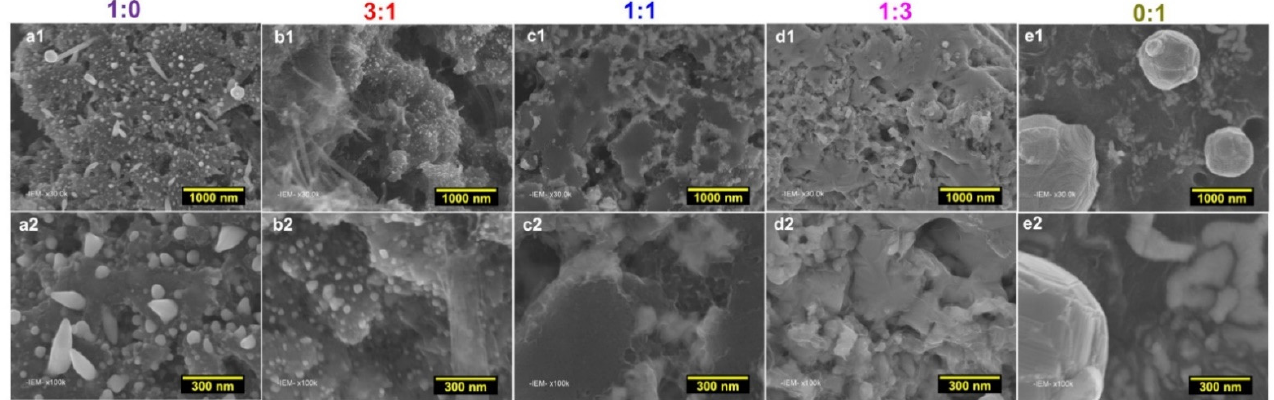
Figure 3. SEM images (at different magnifications) of the as-fabricated electrocatalysts for PANI-Ni:PANI-Co ratios of 1:0 ( a1 , a2 ), 3:1 ( b1 , b2 ), 1:1 ( c1 , c2 ), 1:3 ( d1 , d2 ), and 0:1 ( e1 , e2 ) based on atomic ratio of Ni:Co after calcination.